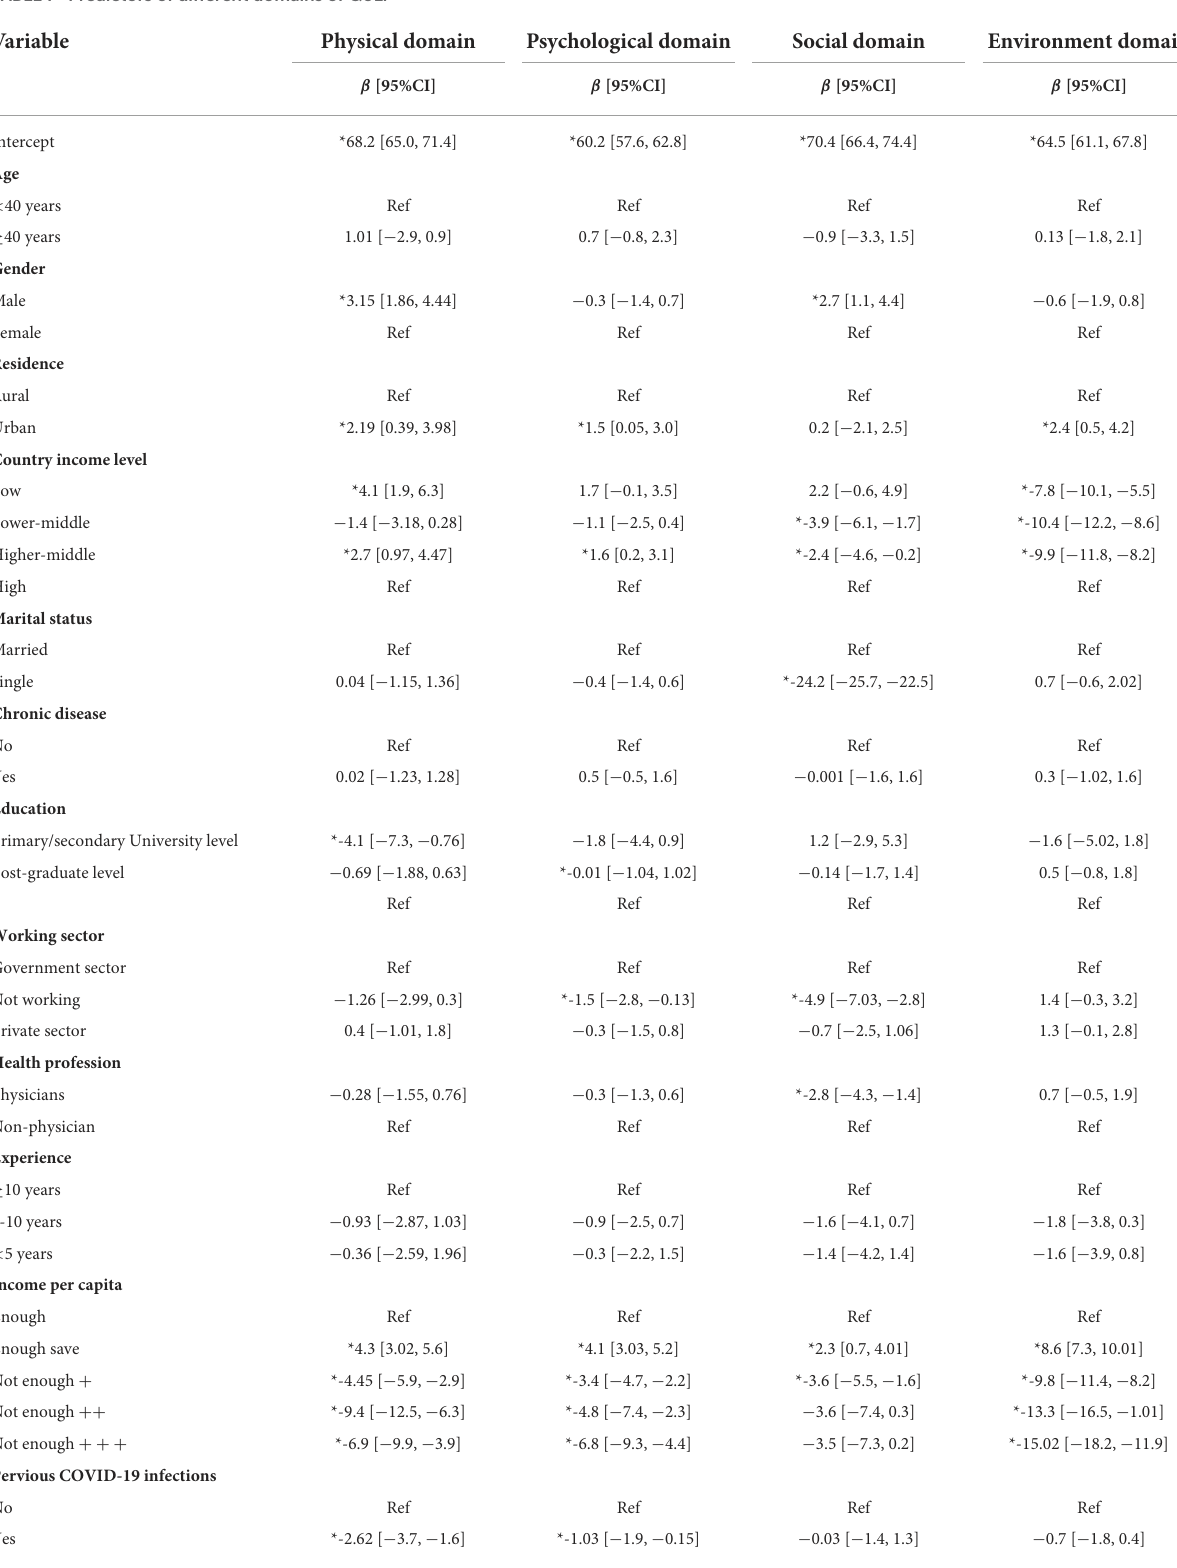
TABLE 7 Predictors of different domains of